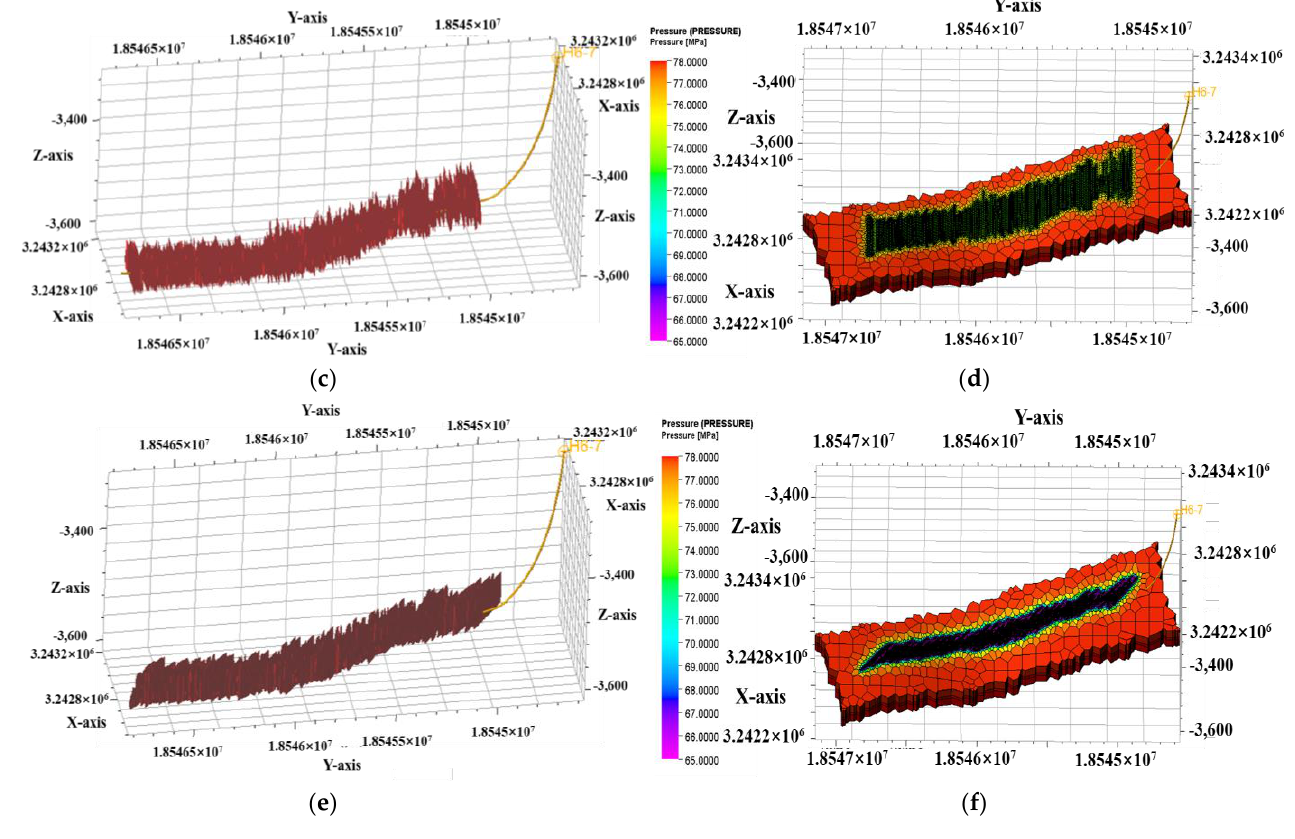
Figure 5. The different well trajectory angles of the fracture propagation: ( a , b ) is the numerical simulation of fracture propagation in 90 ◦ ; ( c , d ) is the numerical simulation of fracture propagation in 70 ◦ ; ( e , f ) is the numerical simulation of fracture propagation in 40 ◦ .